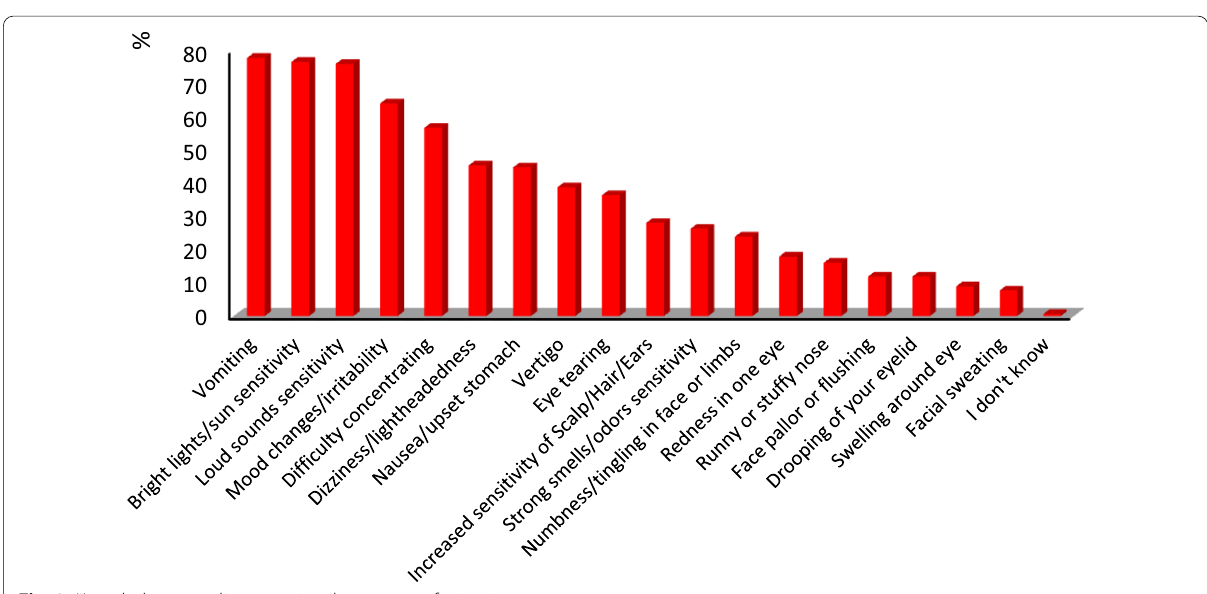
Fig. 3 Knowledge regarding associated symptom of